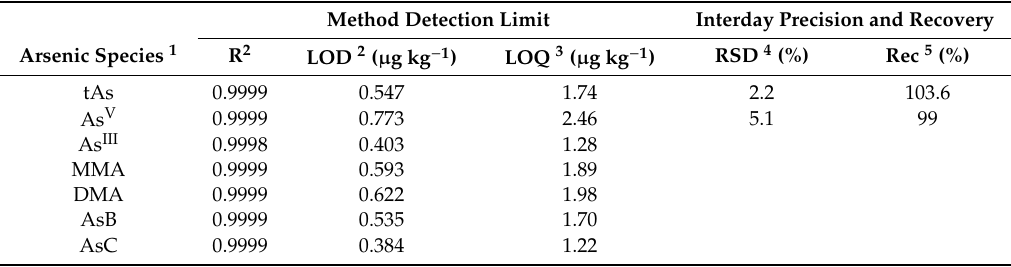
Table 1. Analytical performance of arsenic species in representative samples of seaweed collected from Korean